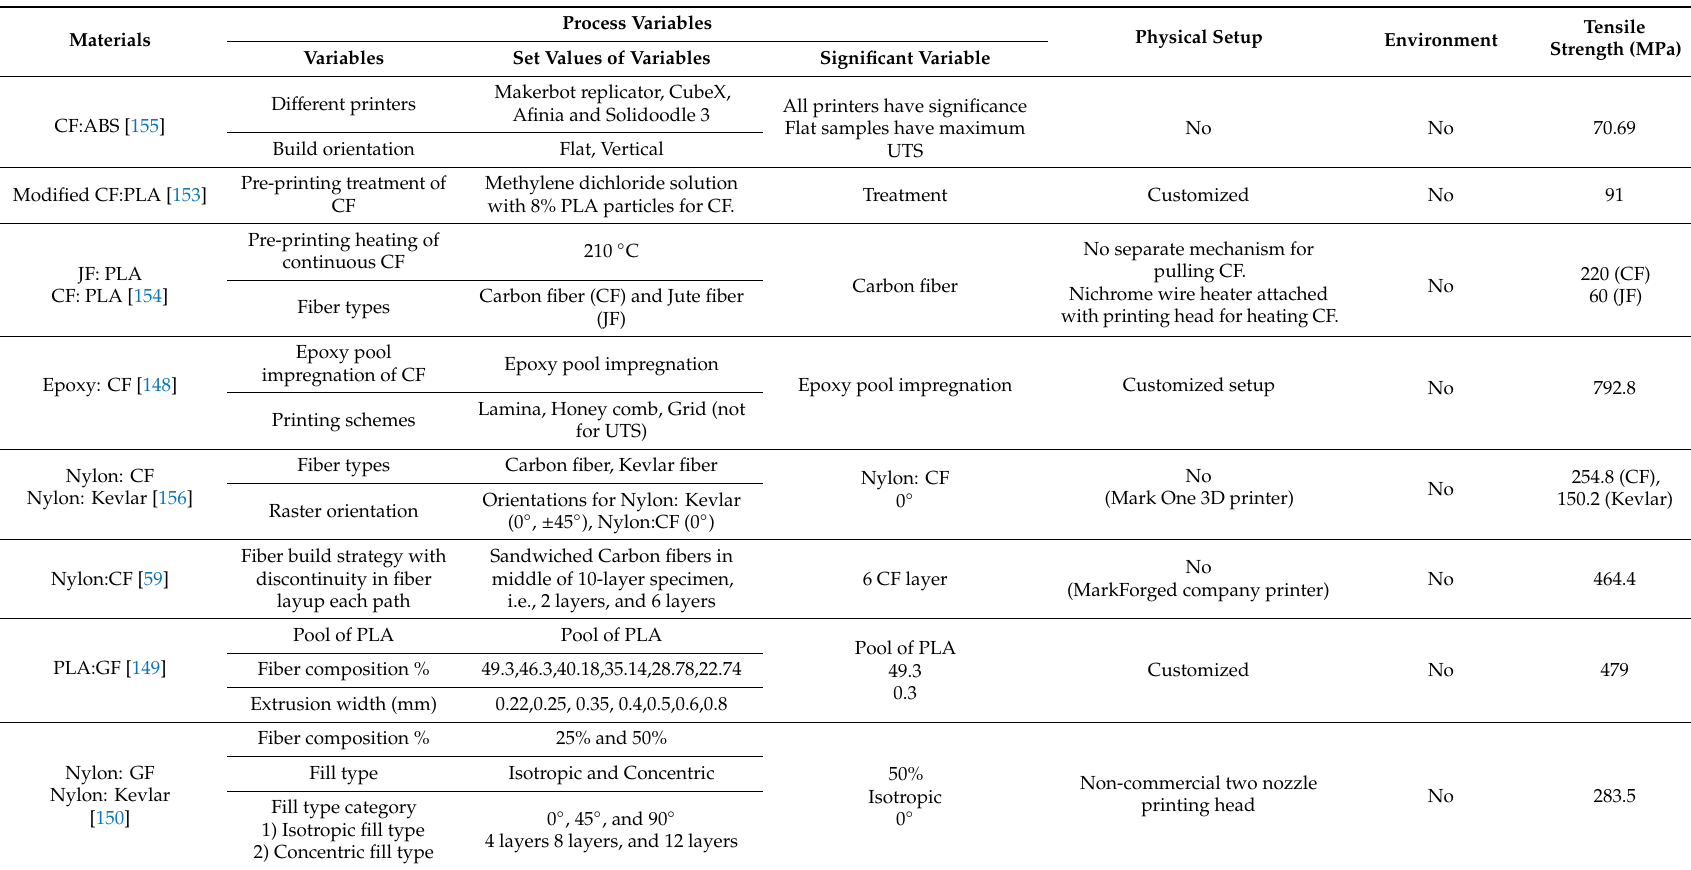
Table 3. Process factors for achieving high tensile strength for continuous fiber reinforced